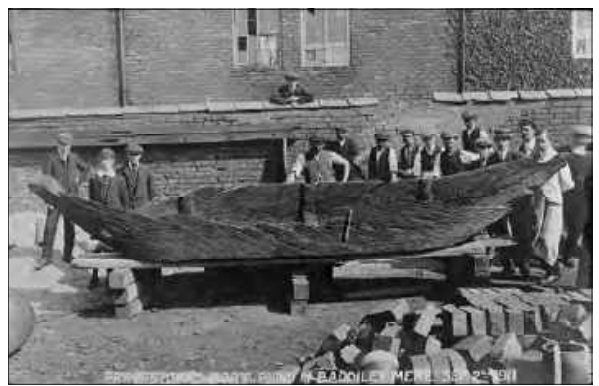
Fig 2.1 A late prehistoric boat of dug out construction, recov- ered from Baddiley Mere in 1911 (Cheshire County Council).